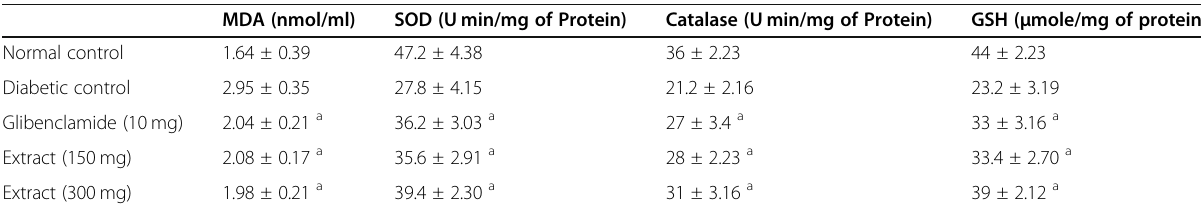
Table 8 Consequences of rhizomes of Sorghum halepense (L.) Pers extract on SOD, MDA, glutathione and